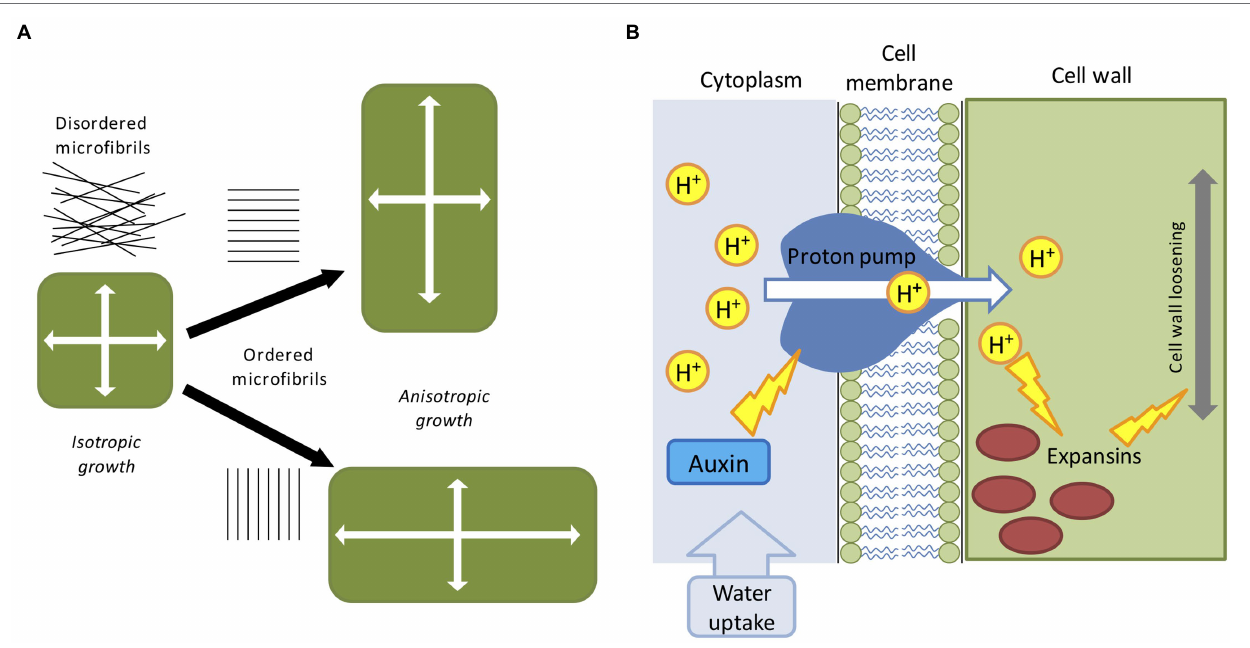
FIGURE 1 | Mechanical and biochemical cues in computer models of plant development. (A) The direction of maximal expansion in plant cells depends on the orientation of cellulose microfibrils. Disordered microfibrils cause the isotropic all-around growth. A globally ordered structure of cellular microfibrils determines the anisotropic elongation, such that the growth direction is biased. (B) The acid-growth hypothesis; auxin promotes the proton pump activity which then acidifies the cell wall through the extrusion of H + into the apoplast. Acidification promotes expansins and other cell wall-related enzymes, leading to the relaxation of the cell wall material, and successive cell